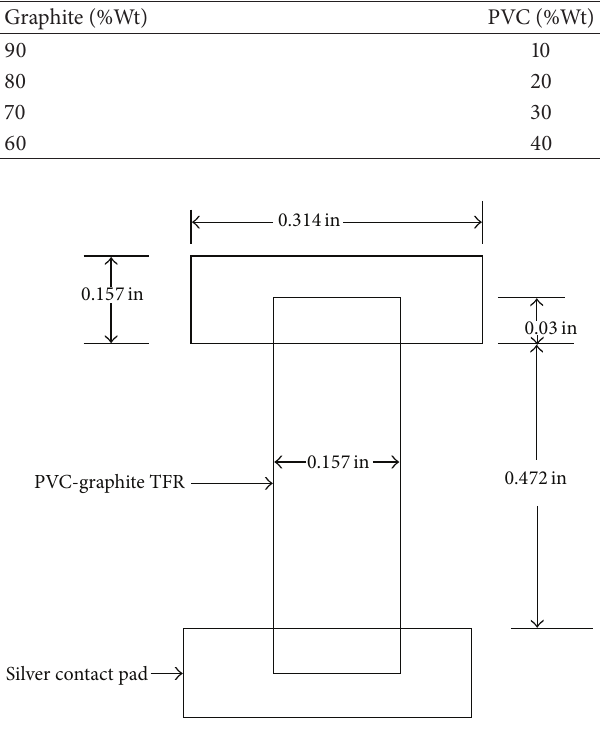
Table 1: Details of resistor compositions.